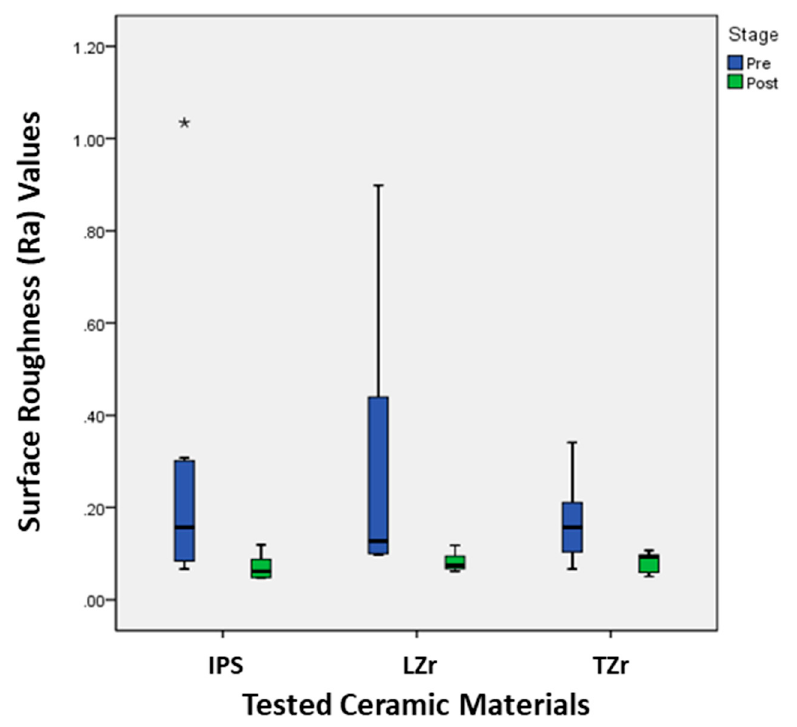
Figure 5. Comparison of surface roughness (Ra) values before and after the bleaching for the three tested ceramics.